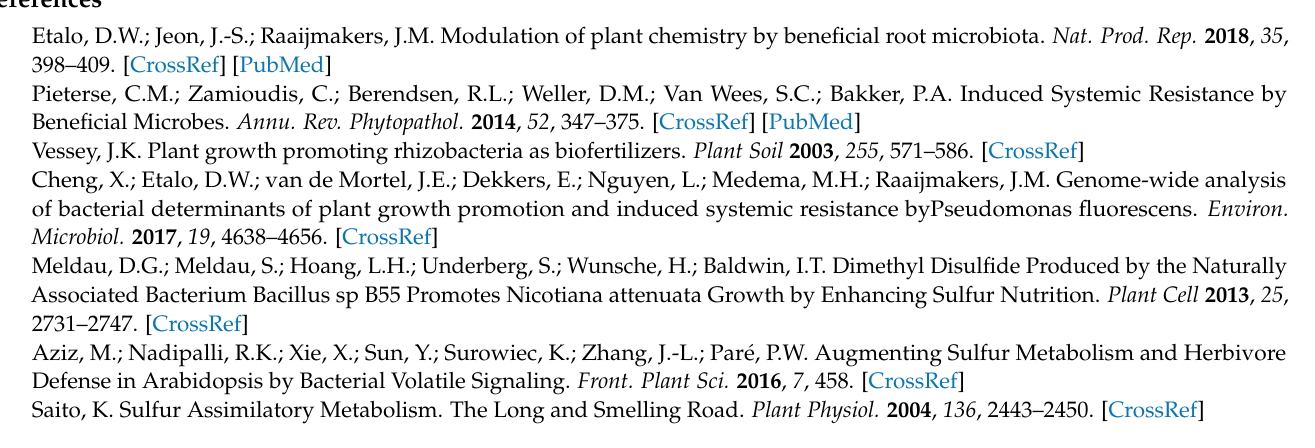
Table S2: Population density of Pseudomonas fluorescens SS101 and cysH -mutant 20H12 on roots of Arabidopsis and two Broccoli cultivars, Coronado and Malibu, at 11 dpi., Table S3: Effects of root treatment of two Broccoli cultivars with the beneficial rhizobacterium Pseudomonas fluorescens SS101, or with its cysH mutant on the phylosphere population density of two pathovars of the bacterial leaf pathogen Xanthomonas campestris at 11 dpi., Table S4: Results of the beta-regression analysis of disease severity caused by Xanthomonas on leaves two Broccoli cultivars (Coronado and Malibu) that were pretreated on the roots with Pseudomonas fluorescens SS101 or its cysH mutant., Table S5: Level of three glucosinolates (GLSs: glucoiberin, glucoraphanin and glucobrassicin) in the shoot of the two Broccoli cultivars, Coronado and Malibu, Table S6: Annotation of Arabidopsis shoot metabolites that showed significant change in their abundance after root inoculation with rhizobacterium Pf SS101: Pseudomonas fluorescens SS101, or its mutant 20H12: cysH mutant of Pf SS101., Table S7: Annotation of Broccoli shoot metabolites that showed significant change in their abundance after root inoculation with rhizobacterium Pf SS101: Pseudomonas fluorescens SS101, or its mutant 20H12: cysH